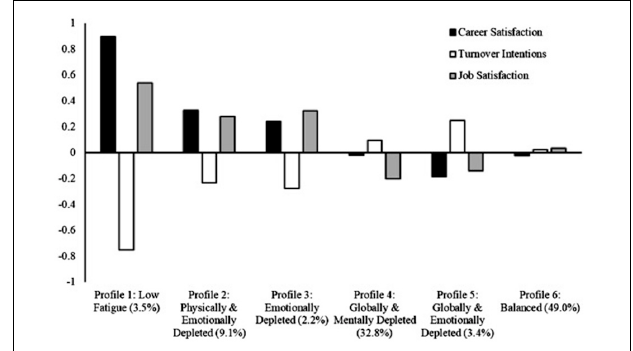
FIGURE 2 | Outcome means for the six-profile distributional similarity model. Outcomes are factor scores with a mean of 0 and a standard deviation of 1.